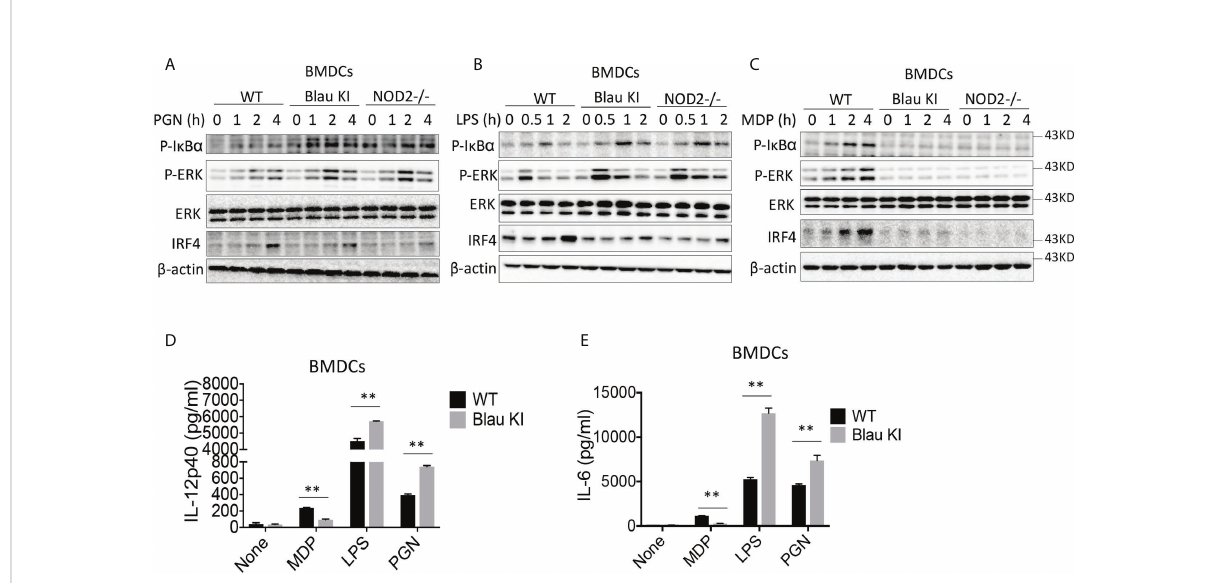
FIGURE 7 The BS-NOD2 Mutation Causes Loss of NOD2 Cross-Regulation of TLR Responses in vitro . (A – C) BMDCs obtained from Blau-KI mice, their wildtype littermates and NOD2 KO mice were stimulated with PGN (1 m g/ml, A ), LPS (1 m g/ml, B ) or MDP (50 m g/ml, C ) for various time periods as indicated; the cells were then lysed and the lysates were subjected to Western blotting for detection of phosphorylation of I k B a , ERK, and IRF4. (D, E) BMDCs from Blau-KI mice and their wildtype littermates were incubated with LPS (100 ng/ml) or PGN (100 ng/ml) for 24 hours; the culture supernatants were then collected for assay of IL-6 (D) and IL-12p40 (E) by ELISA. Data in (A – C) are representative of three independent experiments. Data were analyzed using a two-way ANOVA with Tukey ’ s multiple comparisons and are displayed as mean ± SEM;